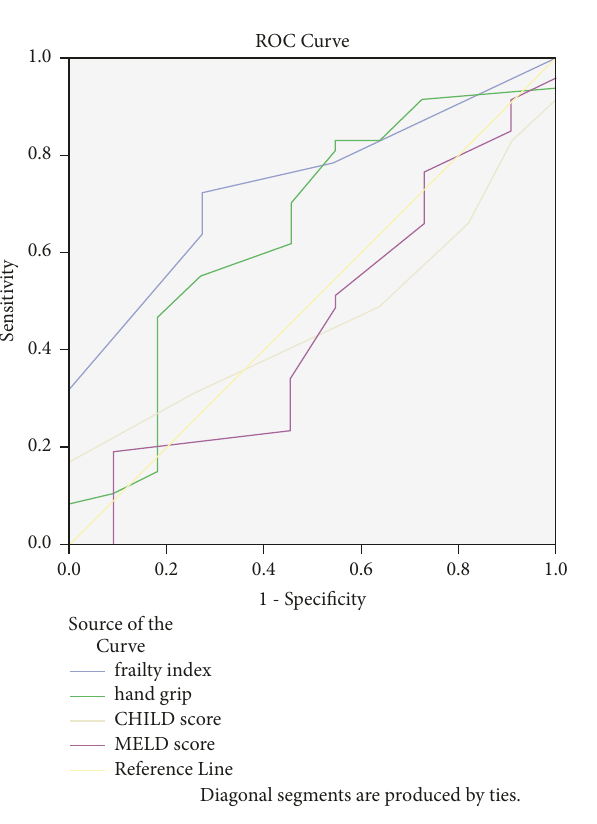
Figure 1: ROC curvefor mortality predictorsamong inpatientswith liver